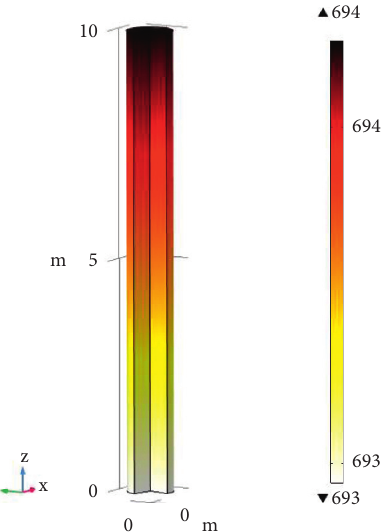
Figure 2: Temperature profile.